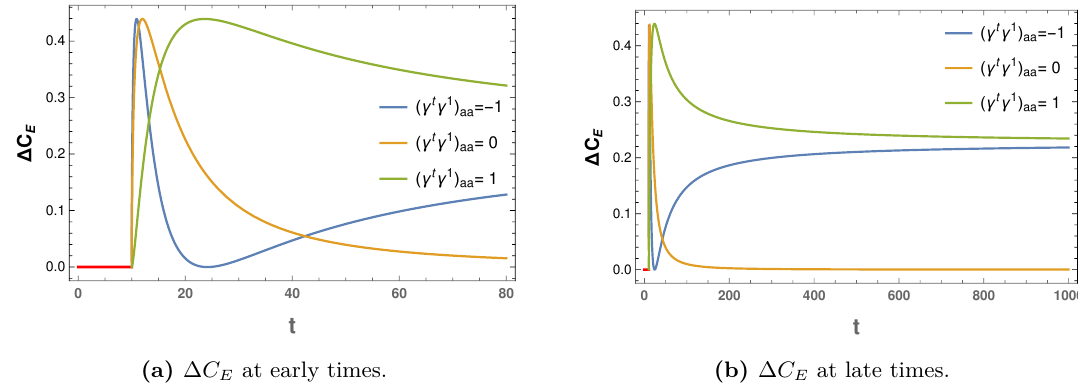
Figure 4. Time evolution of excess capacity ∆ C E with various choices of ( γ t γ 1 ) aa = 0 , ± 1 . Note that for ( γ t γ 1 ) aa = 0 , capacity approaches zero as time evolves. This is attributed to the formation of EPR pairs. For ( γ t γ 1 ) aa = ± 1 it approaches a constant value ( ≈ 0 . 2263 ) at late times. The maxima for the capacity occurs at t = 10 . 9293 , 11 . 9968 , 23 . 6386 for γ = − 1 , 0 , 1 respectively. For all the cases, the maximum value of capacity is 0 . 4392 . Here we choose L = 10 , although the maximum value does not depend on L . The red line corresponds to t < L